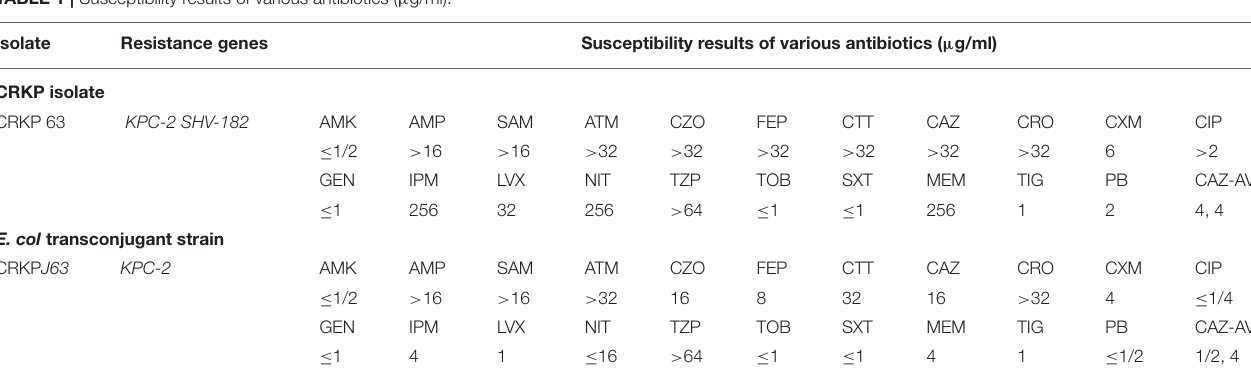
TABLE 1 | Susceptibility results of various antibiotics ( µ g/ml).